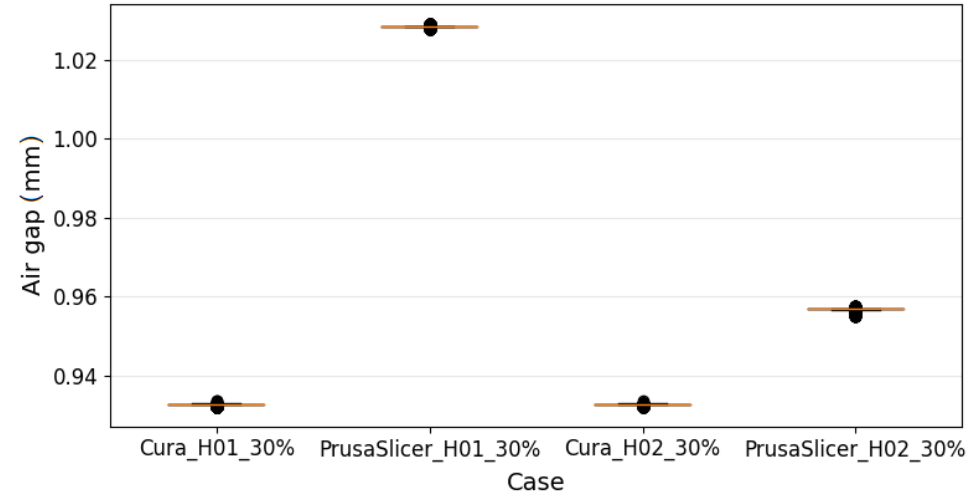
Figure 9. The in-plane distances between the fibers.